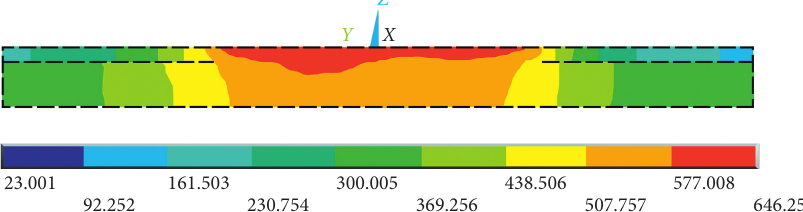
Figure 11: Cloud image of temperature distribution of the cross section in the solder joint centre at 1200r/min, d � 0.3mm, and t � 90s.